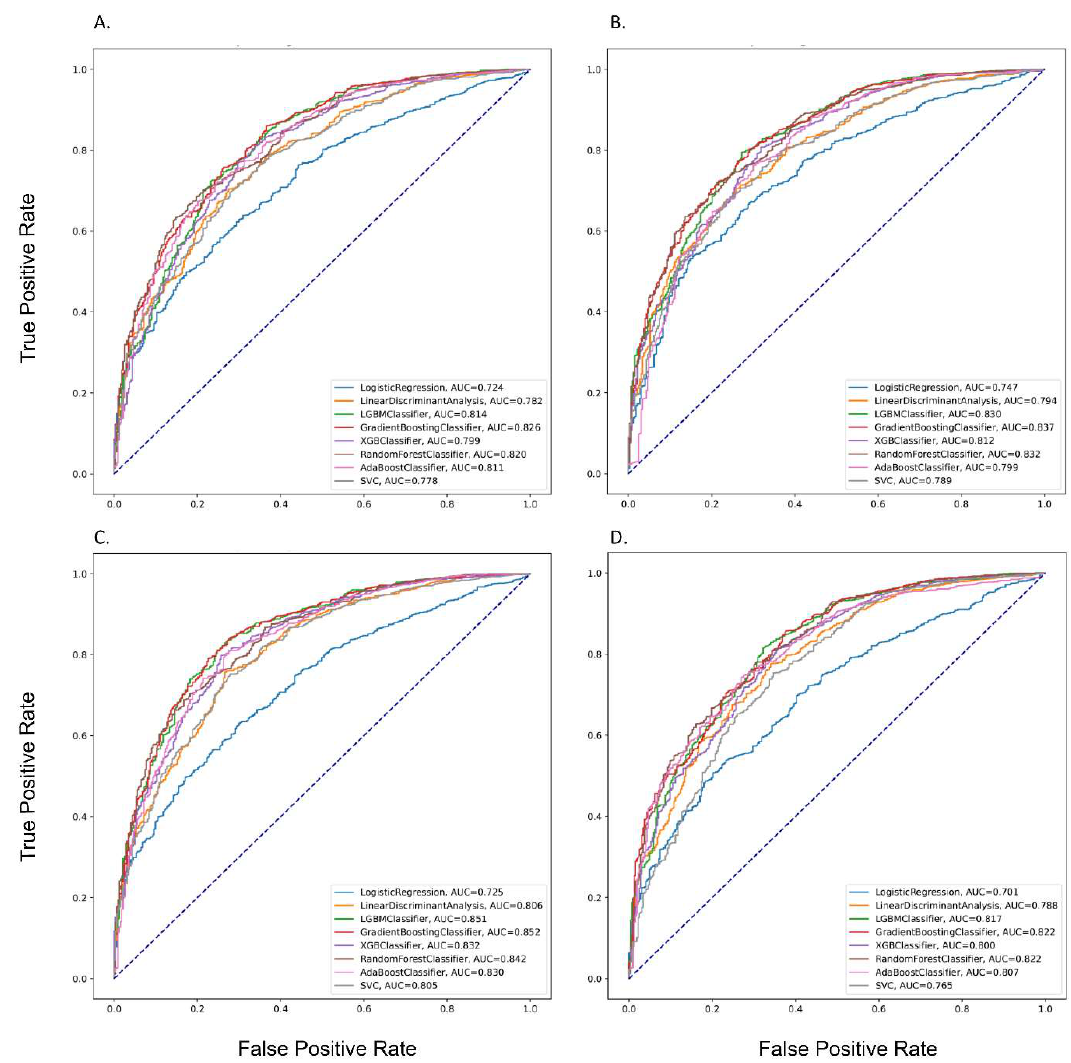
Figure 1. The Performance of the Prediction Models in the Testing dataset by different Modes.